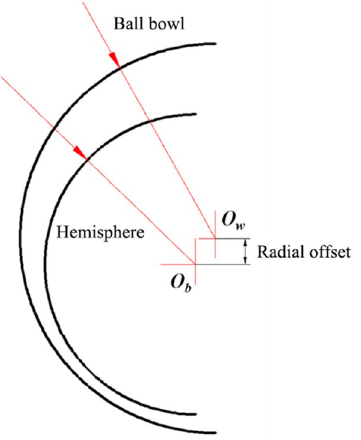
Figure 8. Radial offset of motor.